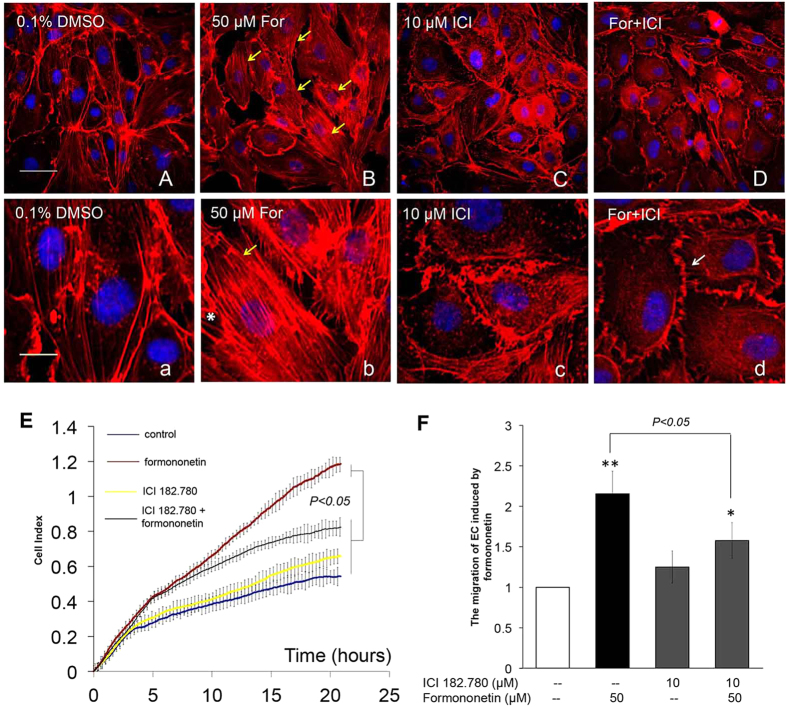
Blockade of ERα activity by ER antagonist ICI 182,780 abolished formononetin-induced stress fiber formation and cell migration in HUVECs.HUVECs were treated with (A,a) 0.1% DMSO for 8 h as negative control and (B,b) 50 μM formononetin for 8 h as positive control. For the experiments with ICI 182,780, HUVECs were first treated with ICI 182,780 (10 μM) for 2 h, followed by washout and the treatments of (C,c) 0.1% DMSO, and (D,d) 50 μM formononetin for 8 h. Cell nuclei were labeled with Hochest 33342 and F-actin was labeled with TRITC-phalloidin. Yellow arrowhead indicated stress fibers terminated at pointed edges. Cortical actin complexes (white arrowhead) were formed in the ICI 182,780 treatment group. (E) Real-time cell migration of HUVECs by using the xCELLigence system showed that ICI 182,780 inhibited formononetin-induced cell migration. HUVECs were treated with ICI 182,780 (10 μM) for 2 h, followed by washout and treatment with 0.1% DMSO or 50 μM formononetin for 24 h. (F) Statistical analysis of HUVECs cell migration following formononetin treatment for 20 h. Results are expressed as percentages of controls (means ± SD; n = 3), **p < 0.01, ***p < 0.001 vs. control.